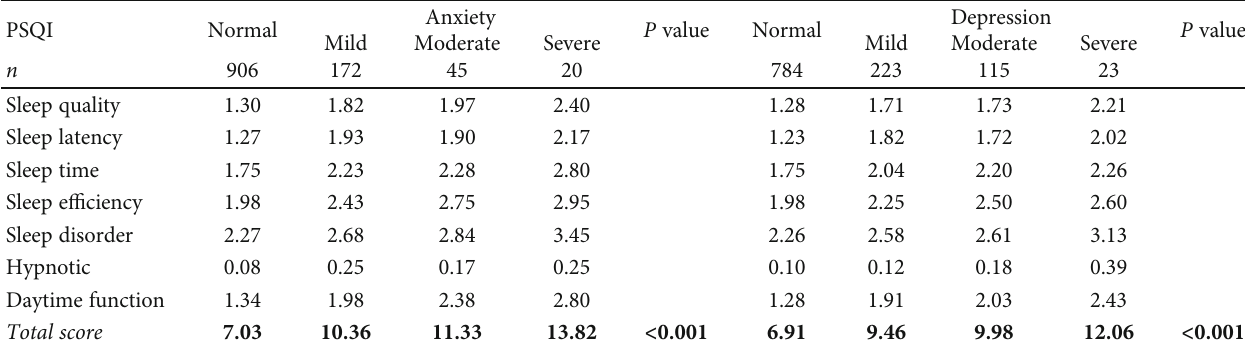
Table 5: PSQI scores in di ff erent degrees of anxiety and depression.